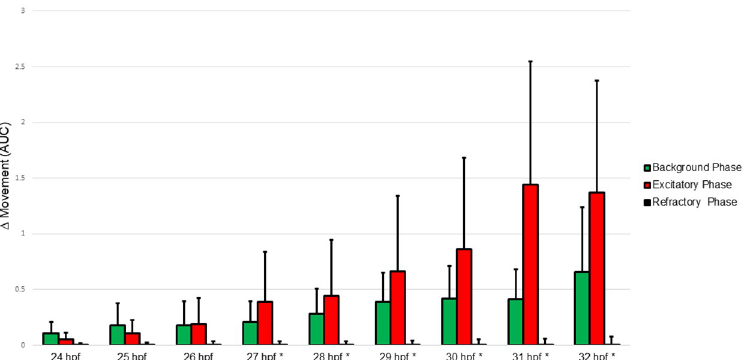
Fig 1. Time series test for the photomotor response of zebrafish embryos. Zebrafish photomotor response by phase. The graph depicts the control response of zebrafish embryos (n = 603) with increasing developmental age. Data generated from the PMR assay was further condensed using the area under the curve calculation by phase with standard deviation bars. Embryos that were found to be non-responders were excluded from the dataset. � = statistically significant increase in movement during the excitatory phase over the background